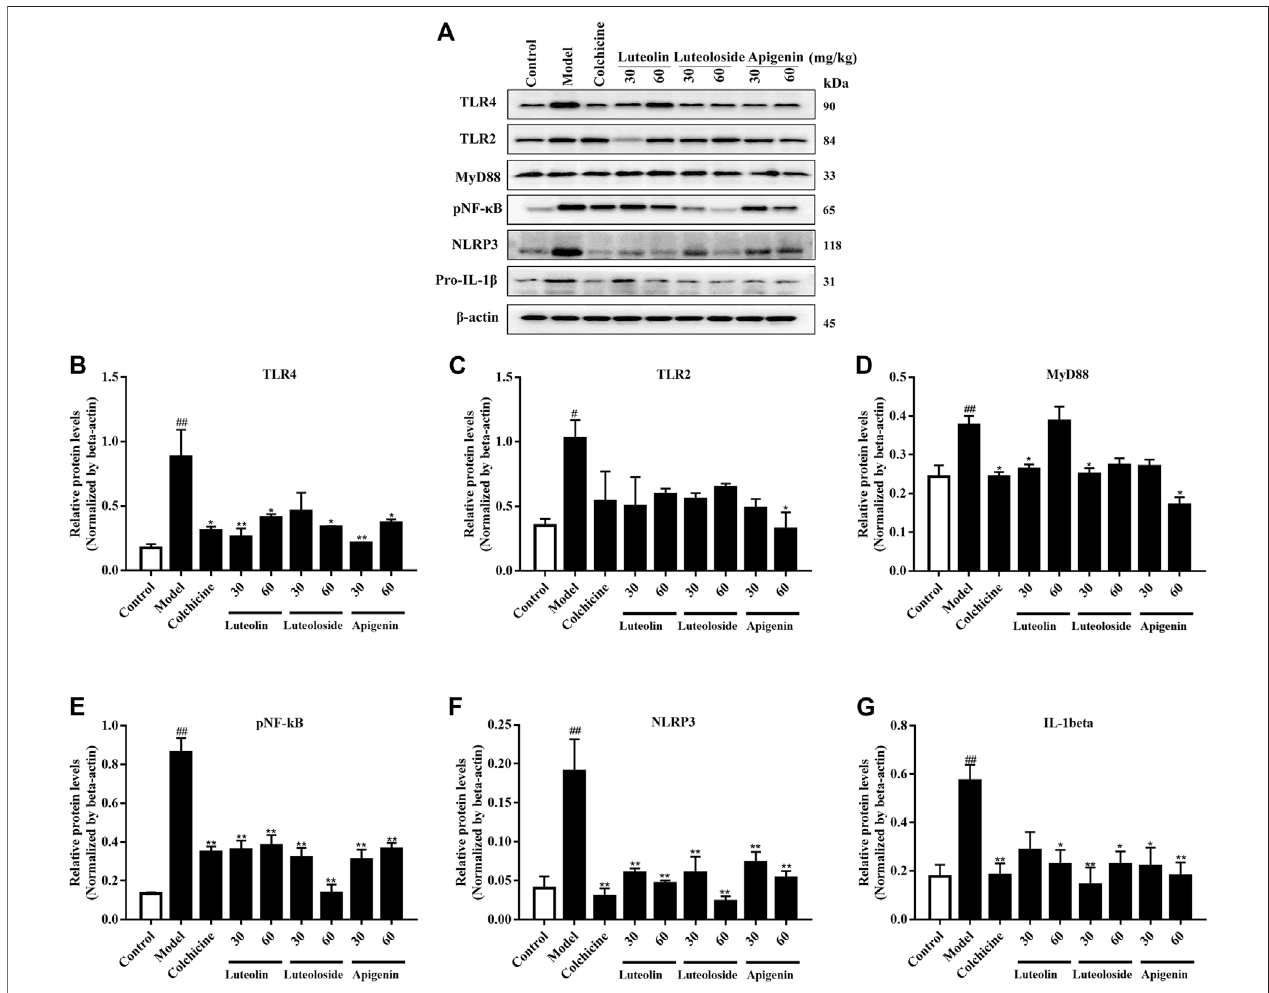
FIGURE 3 | The effects of the active fl avonoids luteolin, luteoloside, and apigenin on the TLRs/MyD88/NF- κ B pathway and NLRP3/IL-1 β expression in MSU crystal-induced gouty arthritis of rats ( n (cid:2) 5). The representative western bands are shown in panel (A) . The changes in TLR4 (B) , TLR2 (C) , MyD88 (D) , pNF- κ B (E) , NLRP3 (F) , and pro-IL-1 β (G ) are shown as histograms. # p < 0.05 and ## p < 0.01 vs. control group; * p < 0.05 and ** p < 0.01 vs. model group.